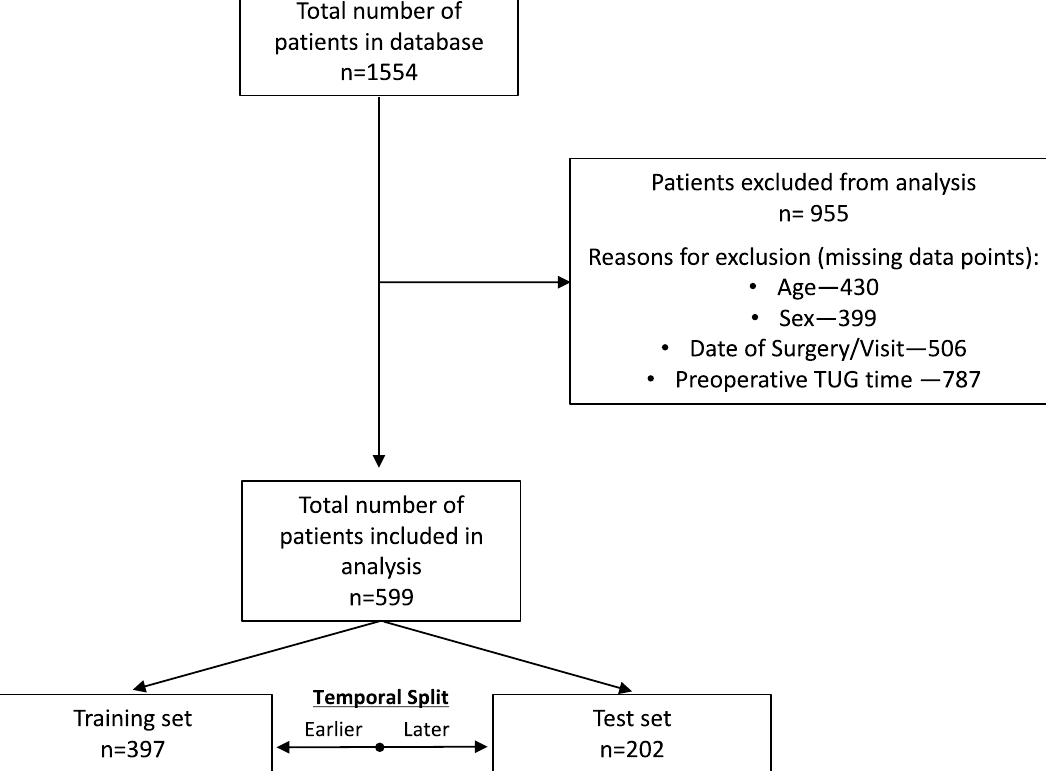
Figure 1. CONSORT flow diagram of patient data included in the